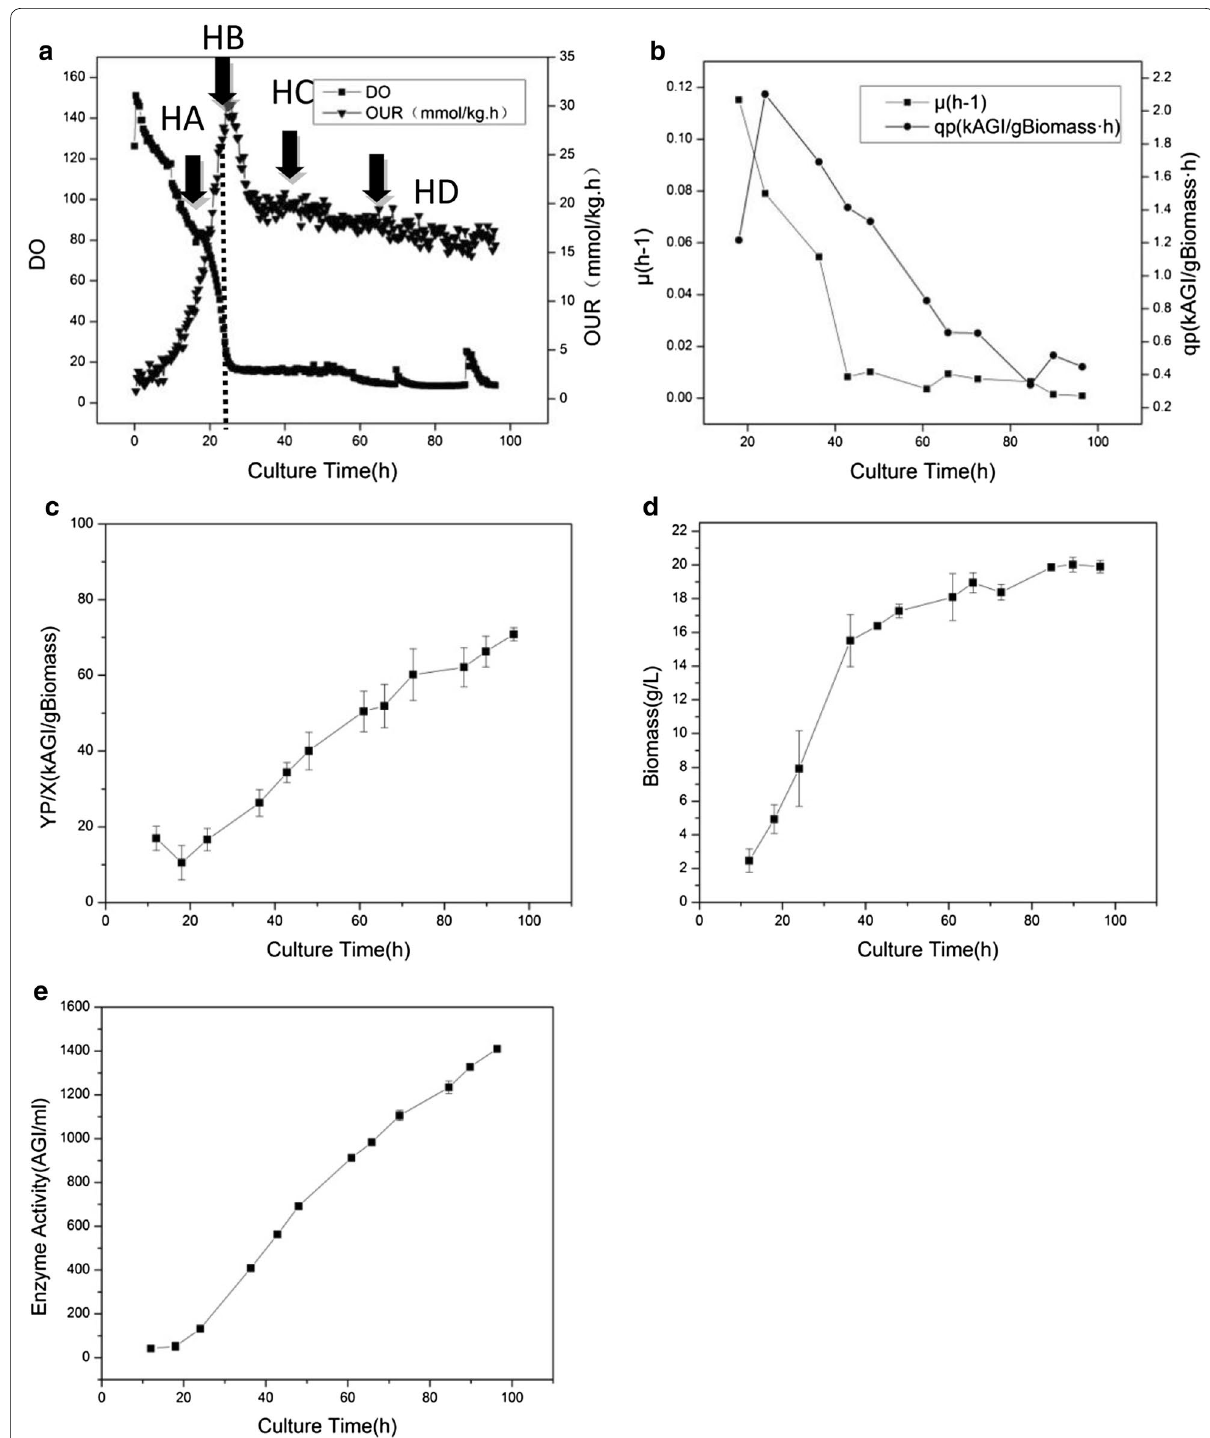
Fig. 1 Growth profiles of A. niger DS03043 during fed‑batch cultivation ( Arrows represents four sampling time points at 16, 24, 42, and 66 h). a Online data of DO and OUR. After the dotted line , it came into the oxygen limitation stage; b off‑line data of μ and q p ; c the yield of glucoamylase to biomass; d the changes of dry weight; e enzyme activity of glucoamylase. All parameters were measured based on triplicate